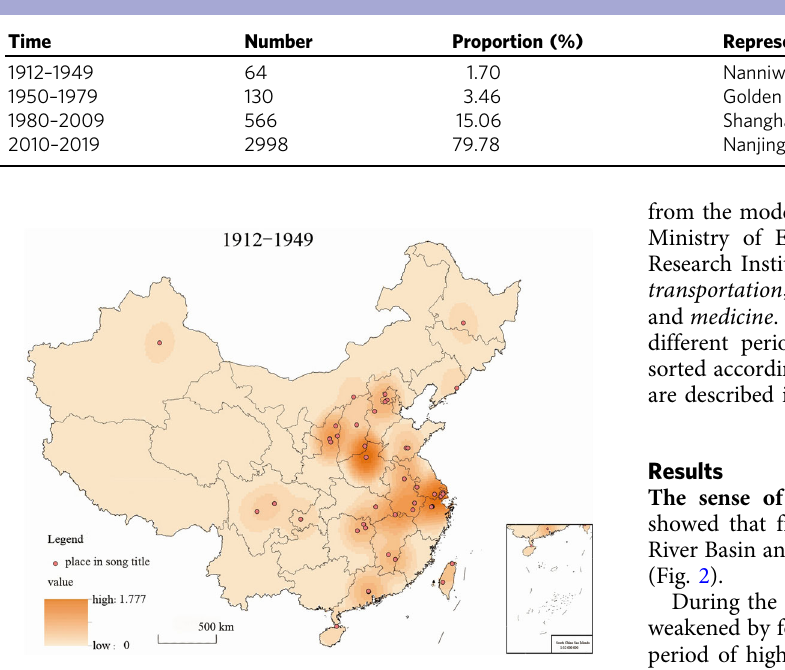
Table 1 Number of songs with names of places for each period of time.